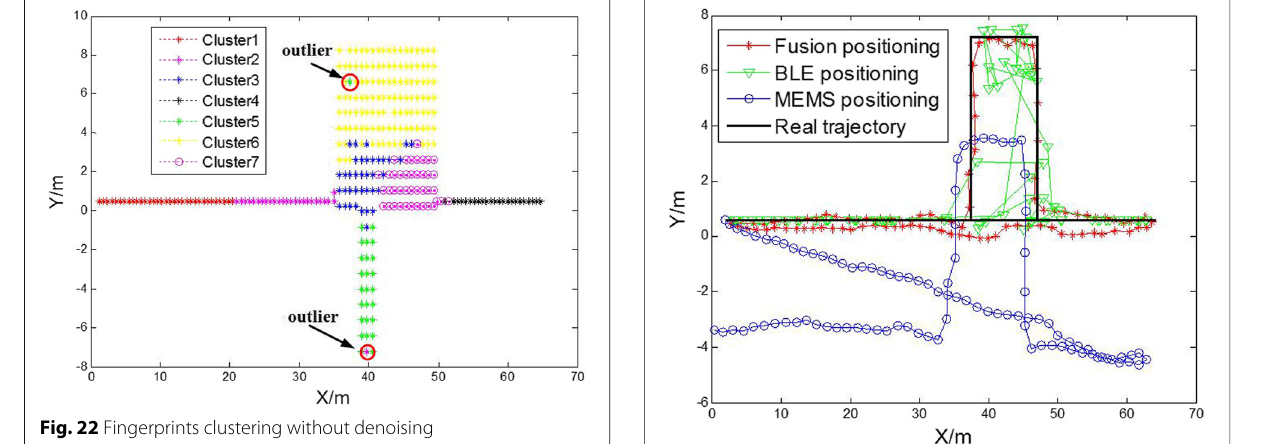
Fig. 25 Locations tracking on a floor